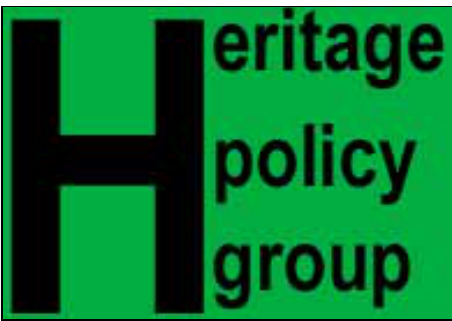
Fig. 1: The new Heritage Policy Group